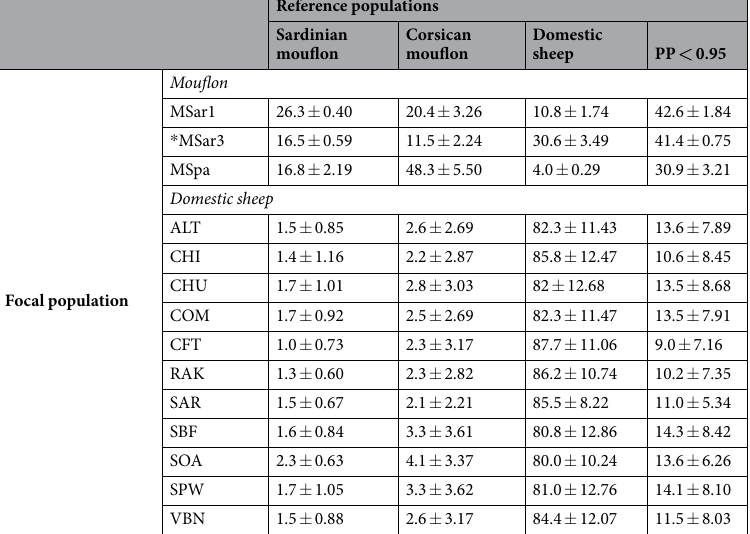
PCAdmix therefore provided estimates of genome-wide admixture proportions for mouflon and domes- tic sheep that were consistent with results from Admixture. However, PCAdmix results for particular genomic regions – the main goal of using this approach - showed inconsistency with regard to the location and length of inferred admixture regions (Fig. 4-d, Supplementary Fig. S7, S8): with the same genomic region being assigned to either mouflon or sheep ancestry, depending on the reference population used in PCAdmix. Consequently, we developed a consensus approach that jointly analysed the results obtained with the four different domestic sheep reference populations, and across all analysed individuals from the focal population, highlighting genomic regions that, independently of the reference population used, showed highly consistent signals of introgression (Fig. 4-c). The CIWI regions obtained with this approach were then crosschecked against all genes covered by (or adjacent to) SNPs on the ovine 50 k BeadChip. On average across mouflon populations, our method identified introgression signals for 524 genes associated with 2,044 CIWIs when using the 95 th percentile confidence thresh- old, and 116 genes associated with 397 CIWIs for the 99 th percentile threshold. Across domestic sheep, a larger number of CIWIs were identified, with on average 996 genes located in 3,205 CIWIs, or 253 genes in 625 CIWIs (based on confidence thresholds of the 95 th and 99 th percentile, respectively; Supplementary Table S3). GO term analysis of introgressed loci. Genes identified within CIWIs in MSar1, MSar3 and MSpa showed no significant enrichment of any gene ontology (GO) terms (FDR ≈ 1), independent of the percen- tile threshold used. Conversely, seven GO terms associated to mouflon ancestry were identified in domestic breeds. All domestic breeds except SOA and SPW were enriched for GO terms involved in protein citrullination (Supplementary Table S4) whereas in both SAR and SOA, GO terms involved in the perception of bitter taste were significantly enriched (Supplementary Table S4). The genes involved in protein citrullination were located in four distinct chromosomal regions: two on chromosome 2, and one each on chromosomes 3 and 25 (Table 3). The genes related to bitter taste perception were located on chromosomes 2, 4 and 16 (Table 3). Similar results were obtained when the CIWI approach was applied to the extended Sardinian mouflon reference using both MSar1_p and MSar2 (resulting in eight ancestry analyses to be compared: two Sardinian mouflon and four domestics sheep reference populations; Supplementary Text S1). However, in this case no significant enrichment of GO terms related to bitter taste perception was detected (Supplementary Table S4).